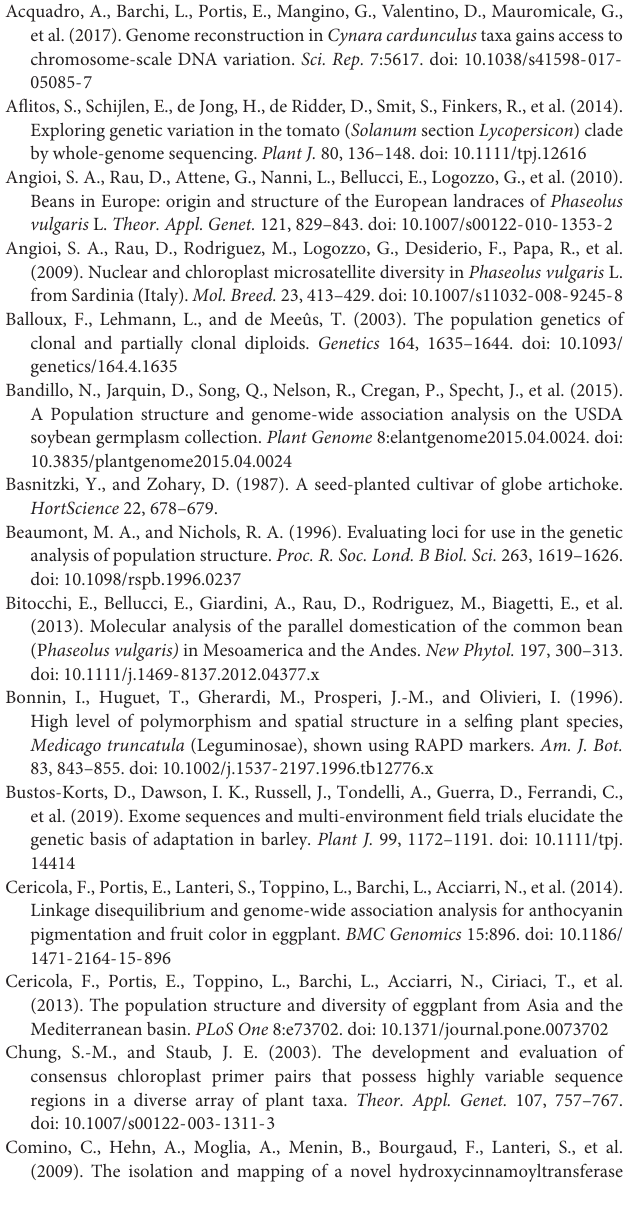
Supplementary Figure 2 | Relationships among the varieties, as shown by the third and fourth discriminant linear functions. The former separated SPI and CAT-VPR from the other groups, and the latter mainly separated ROM and MAC. Supplementary Figure 3 | Individual to groups assignments by discriminant analysis of the principal components. Left: morphological types and name for each accession. Right: composition of each of the SSR genetic groups. Heat colors represent membership probabilities (red = 1, white = 0); blue crosses represent the prior cluster provided to DAPC. DAPC classification is consistent with the original clusters (blue crosses are on red rectangles). Supplementary Figure 4 | Variation at the chloroplast SSRs: (A) within the overall collection; (B) within and across the five nuclear SSR genetic groups of the globe artichoke